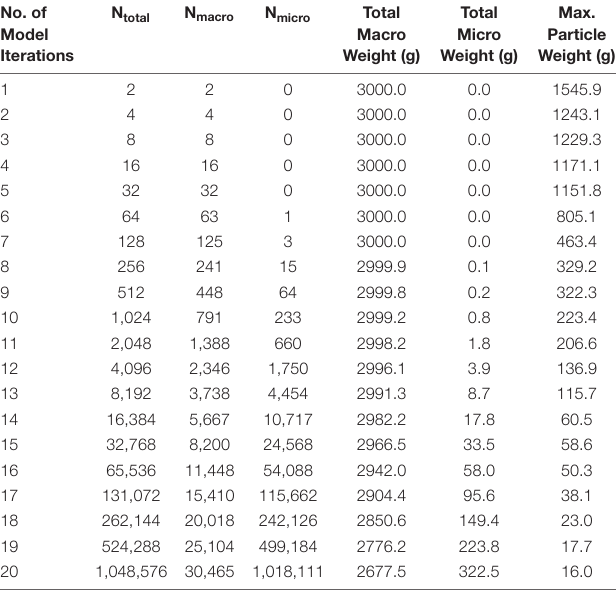
TABLE 4 | Summary of the application of the fragmentation model to a single plastic litter item of 3,000 g. No. of